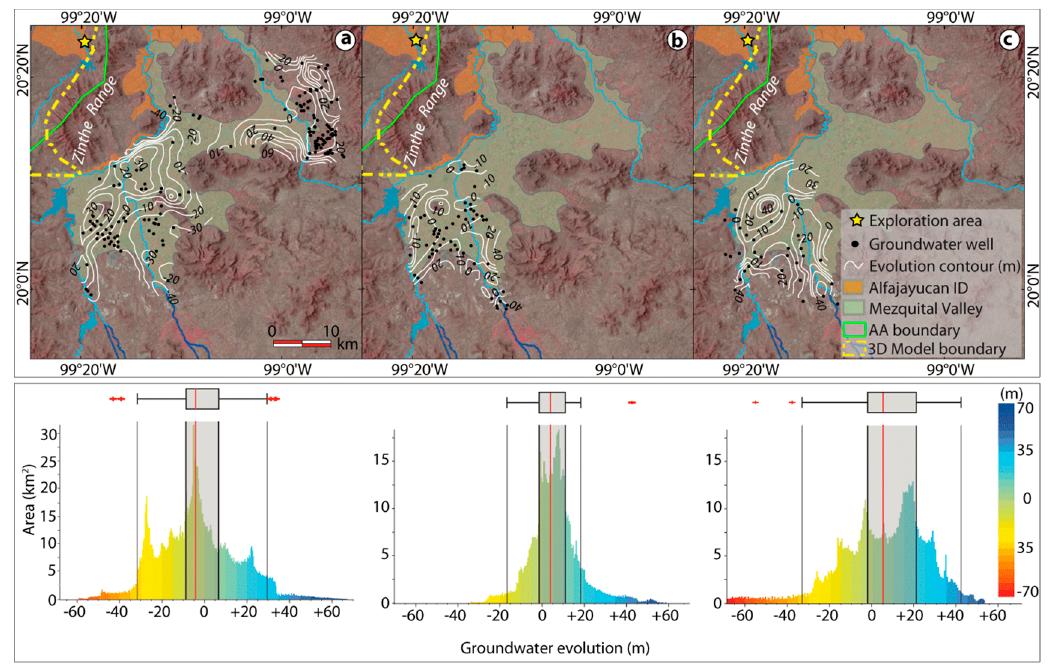
Figure 9. Groundwater evolution in the Mezquital valley aquifer. ( a ) 1982–1998; ( b ) 1998–2007; ( c ) 1982–2007. Negative contours (m) refer to a decline in potentiometric levels and opposite for positive values. ID: Irrigation district. Red crosses in the boxplots refer to outliers. AA: Alfajayucan aquifer.